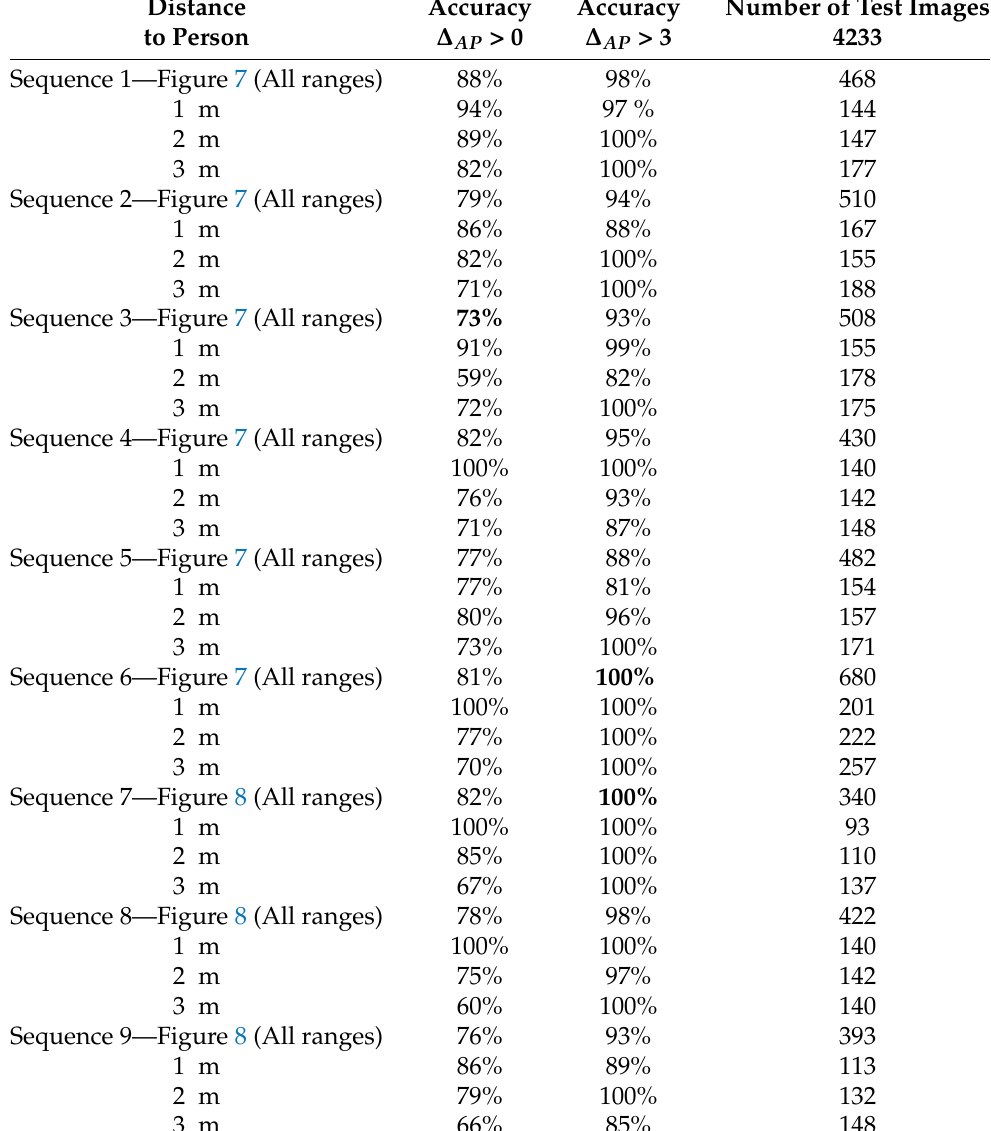
Table 1. Comparison of results for different distances to observed people.